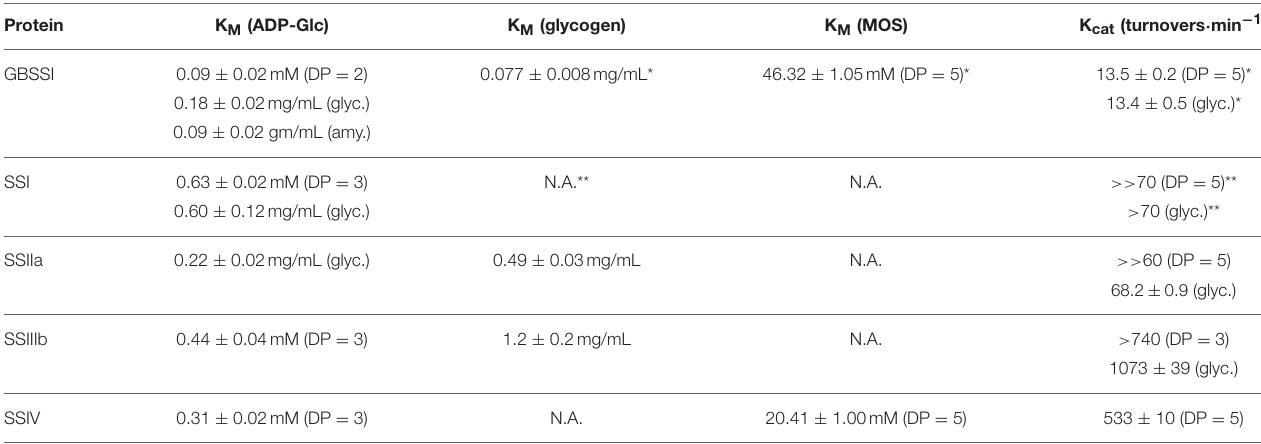
TABLE 1 | K M and K cat constants for all SS classes.